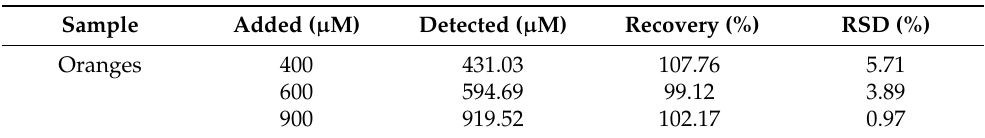
Table 2. Detection of AA in fresh